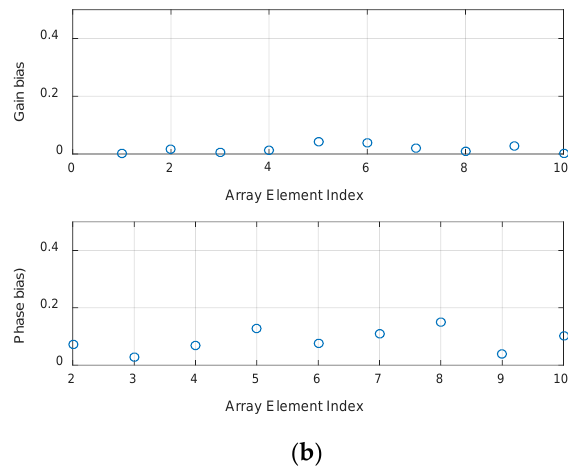
Figure 1. The estimated performance of the gain and phase errors: ( a ) The estimated results compared to the true values; ( b ) The estimated bias.